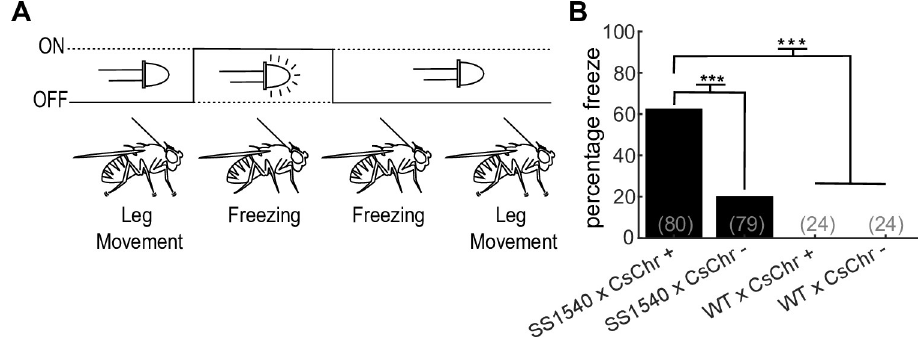
Fig 3. The optogenetics device replicates prior freezing neuron activation studies. ( A ) Annotated response of optogenetic activation of the freezing line shows the fly moving its legs before light stimulation, freezing during and after light stimulation, and then returning to leg motion ( B ) The percentage of flies that freeze with light stimulation (n = flies as stated in figure, χ 2 test, P << .001, Bonferroni correction post hoc, ��� = p < .001). Abbreviations: retinal food (+), standard food (-), SS1540-split-Gal4 (SS1540) CSMH wild type (WT), UAS-CsChrimson (CsChr).